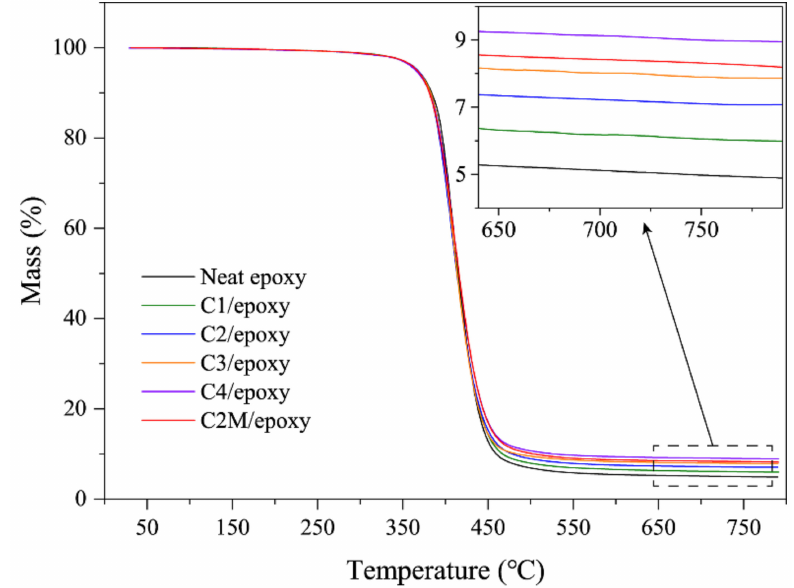
Figure 3. TGA plots of neat epoxy, ASCF/epoxy composites and MXene functionalized ASCF/epoxy composites under a nitrogen